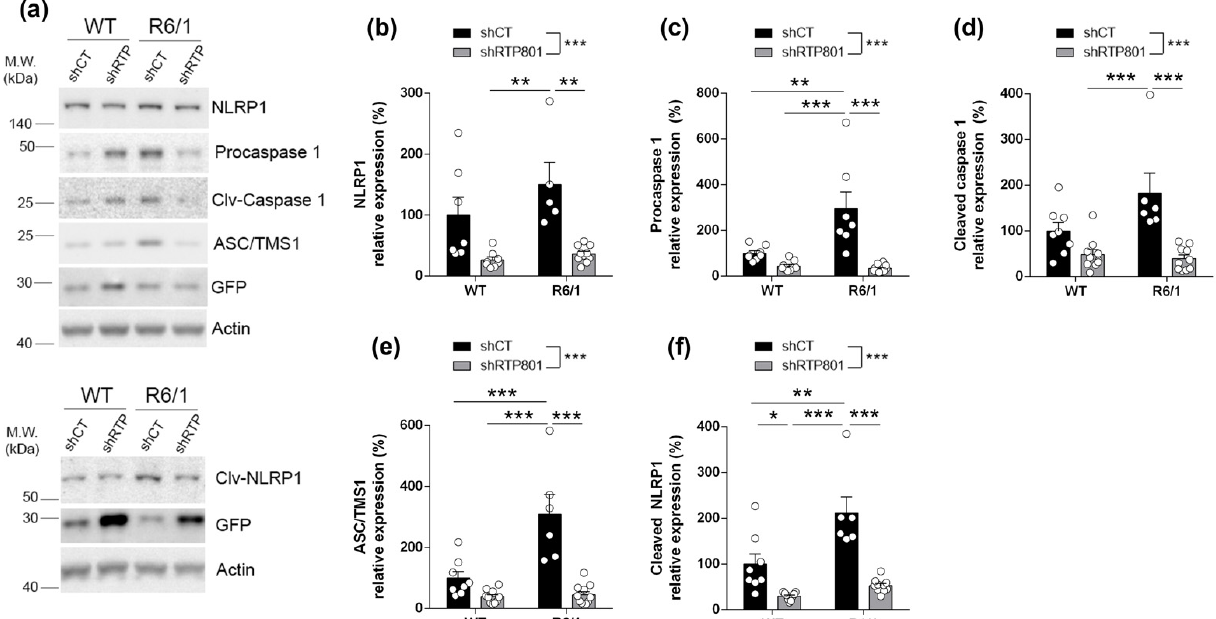
Figure 5. RTP801 silencing in the R6/1 mouse hippocampal neurons reduces the levels of the inflammasome components. ( a ) Immunoblottings for NLRP1, cleaved NLRP1, procaspase 1, cleaved caspase 1, ASC/TMS1, and GFP as loading control for transduced neurons in the dorsal hippocampus of 4.5-month-old WT shCt, WT shRTP801, R6/1 shCt, and R6/1 shRTP801